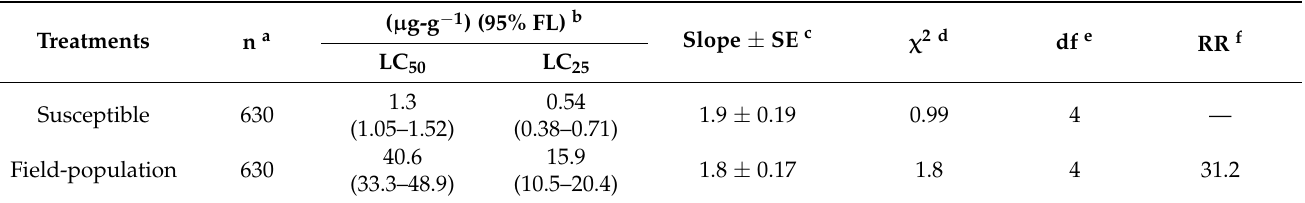
Table 1. Toxicity of Noposion Yihaogong ® 5% EC insecticide to early third-instar Spodoptera frugiperda larvae. Treatments